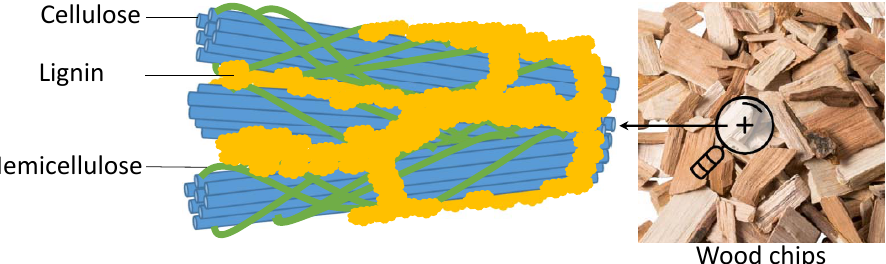
Figure 2. Arrangement of cellulose, hemi-cellulose and lignin in